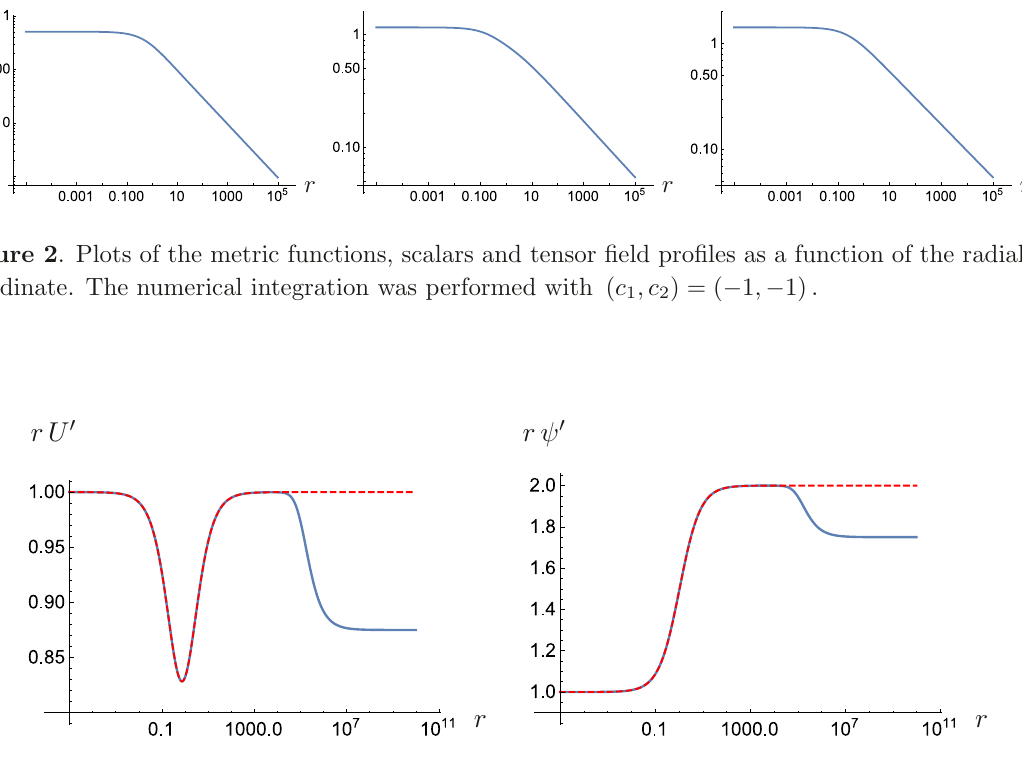
Figure 3 . Plots of the logarithmic derivatives of the metric functions. The red, dashed line corresponds to the metric functions in the asymptotically AdS 4 solution (4.14). The blue, straight curve was produced numerically with ( c 1 , c 2 ) = (0 ,